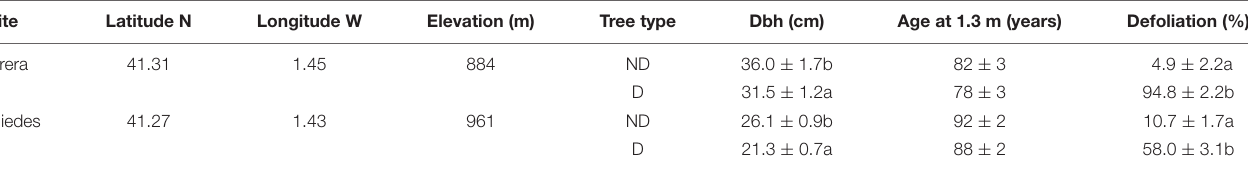
TABLE 1 | Main features of the study sites and sampled trees. Site Latitude N